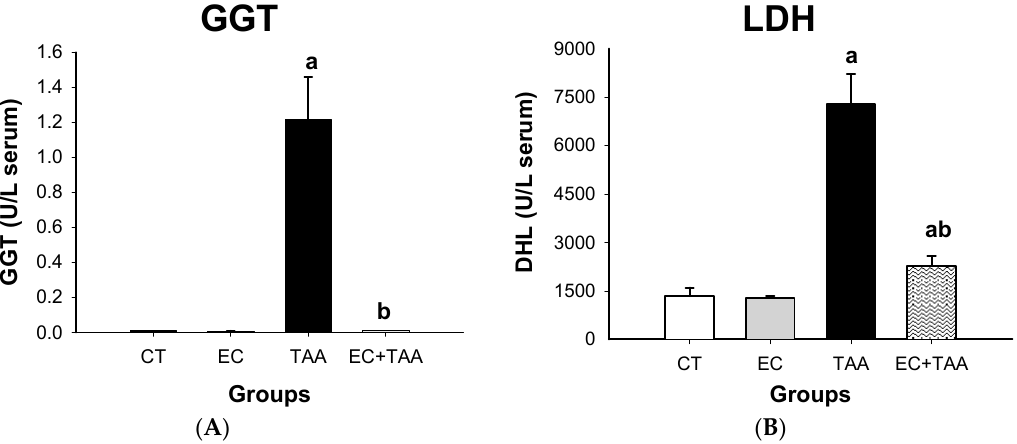
Figure 4. E ff ect of EC pretreatment on the levels of ( A ) GGT and ( B ) LDH analyzed by Wiener Lab equipment in the serum of rats intoxicated with a sublethal dose of thioacetamide (TAA). The results are expressed in U / L of serum. Bars indicate the mean value with the SE of two determinations (n = 8). The di ff erences compared with the vehicle are expressed as “ a ”; while the di ff erences due to TAA are expressed as “ b ”, p ≤